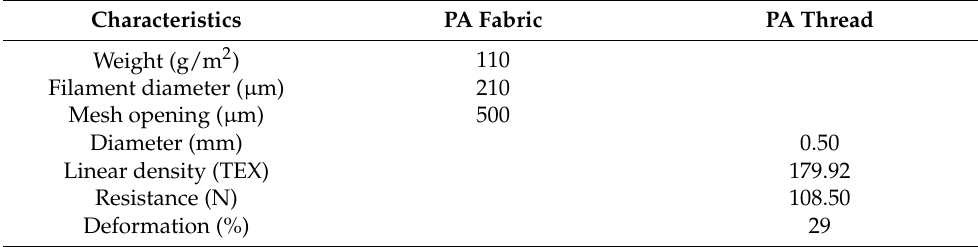
Table 3. Characteristics of the PA fabric (Monodur ® from Cadisch Precision Meshes) and PA thread (Passat20 from Hicoman).